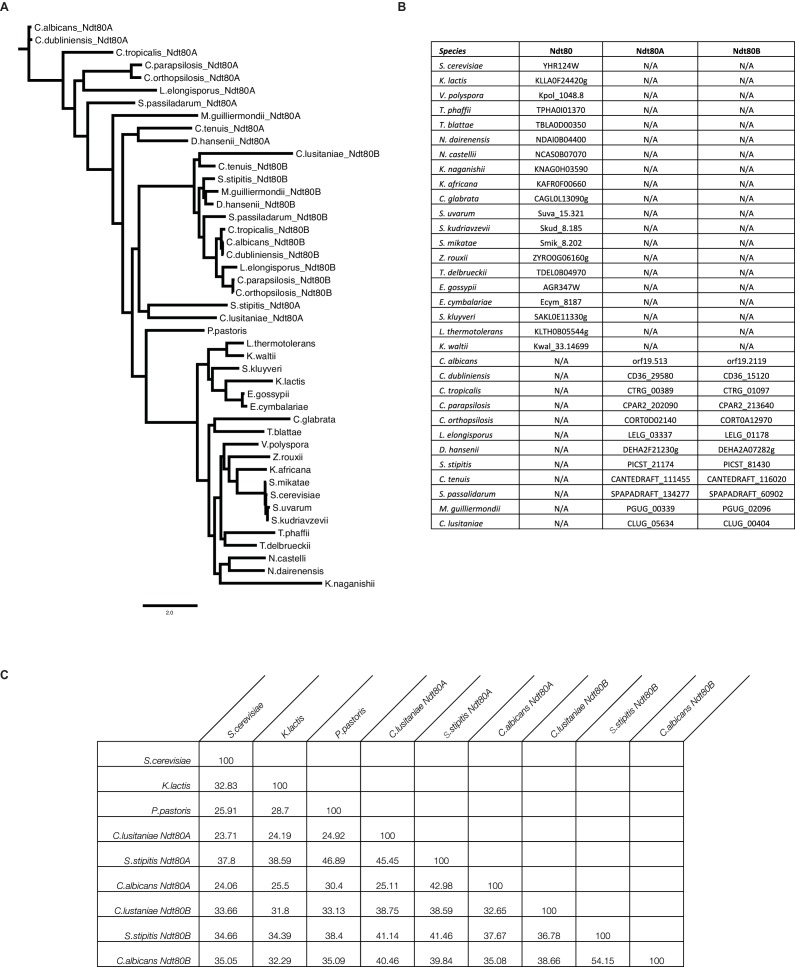
Similarity of Ndt80 protein sequences across many yeast species.(A) Phylogenetic tree of Ndt80 proteins in diverse ascomycetes, built using MUSCLE (Edgar, 2004) and PHYML (Guindon et al., 2010). Scale bar indicates substitutions per site. (B) List of genes used in the phylogenetic tree, and in the manuscript. (C) Similarity matrix of Ndt80 proteins for species discussed in this work, calculated using MUSCLE.